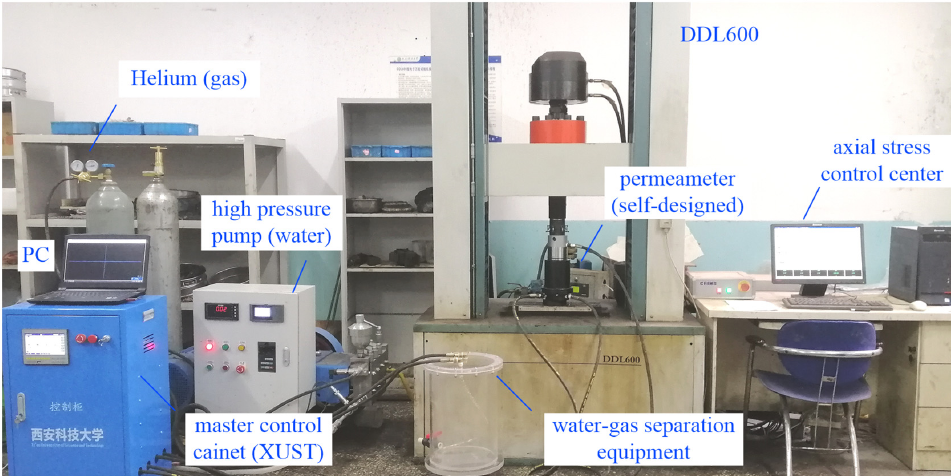
Figure 5. Water–gas two phase seepage test system for fractured coal bodies.